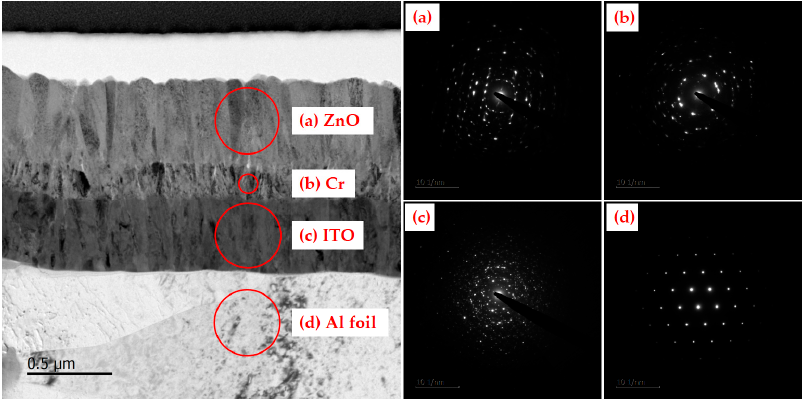
Figure 8. LRTEM (200 KeV) cross-sectional image ( left ) and SAED patterns ( right ) of the ZnO / Cr / ITO stacked layers deposited on the Al-foil substrate. The SAED patterns indicate that polycrystalline ( a ) ZnO, ( b ) Cr, and ( c ) ITO films were deposited as expected. ( d ) Polycrystalline face-centered cubic (FCC) structure of the Al film. The scale bar represents 0.5 µ m.